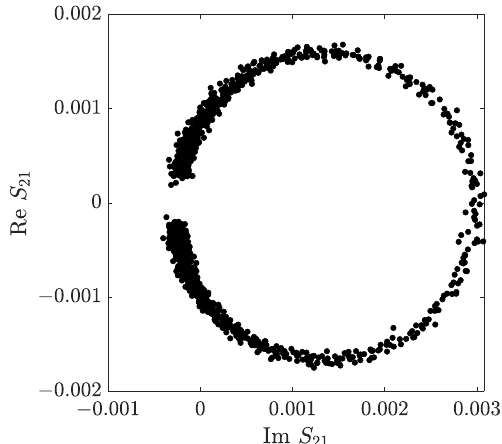
Figure 6. Measurement of the S 12 parameter on the complex